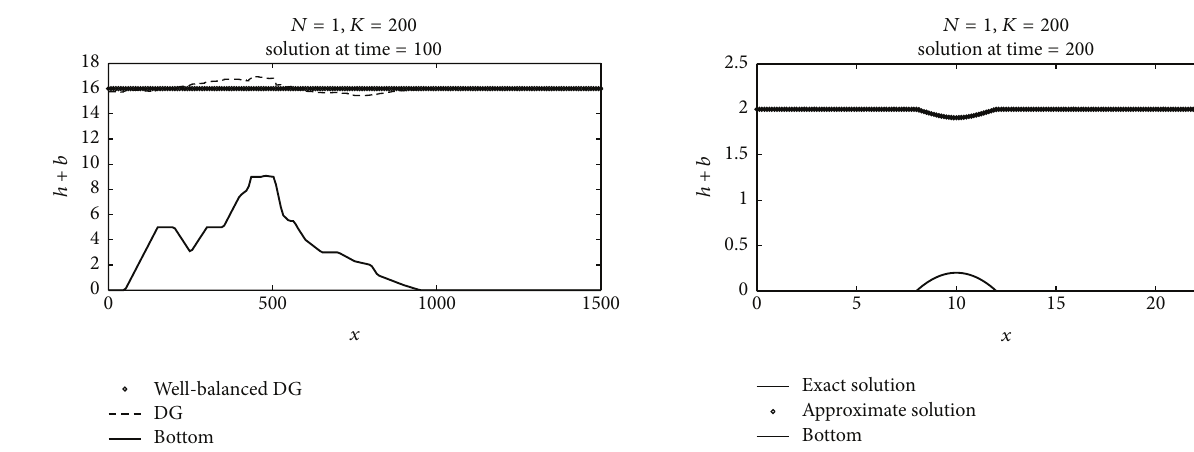
Figure 3: Stationary flow over irregular bed by well-balanced and non well-balanced TVD-RK DG with WAF method.